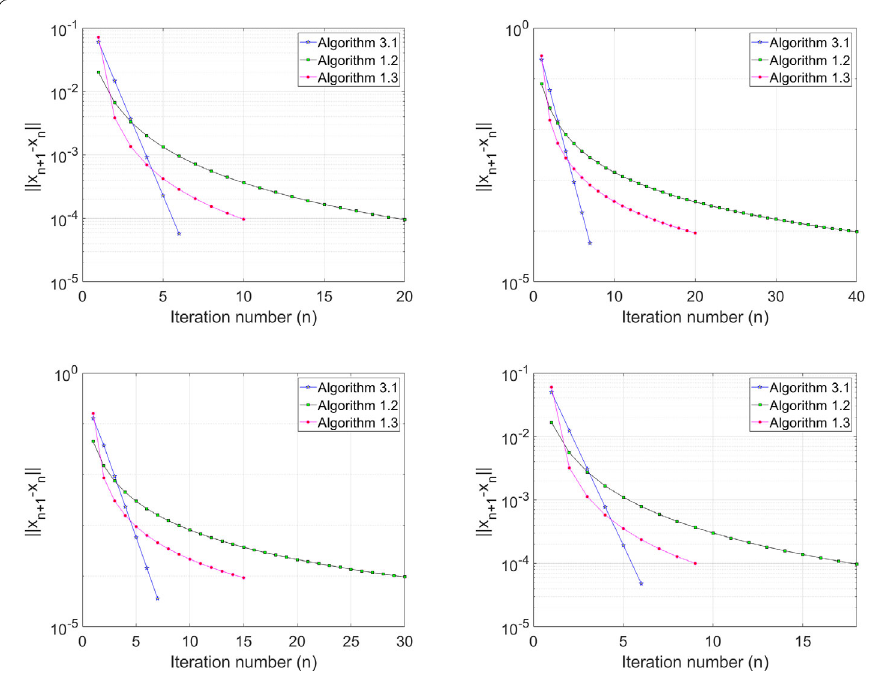
Figure 3 Example 4.1, top left: Case I; top right: Case II; bottom left: Case III; bottom right: Case IV